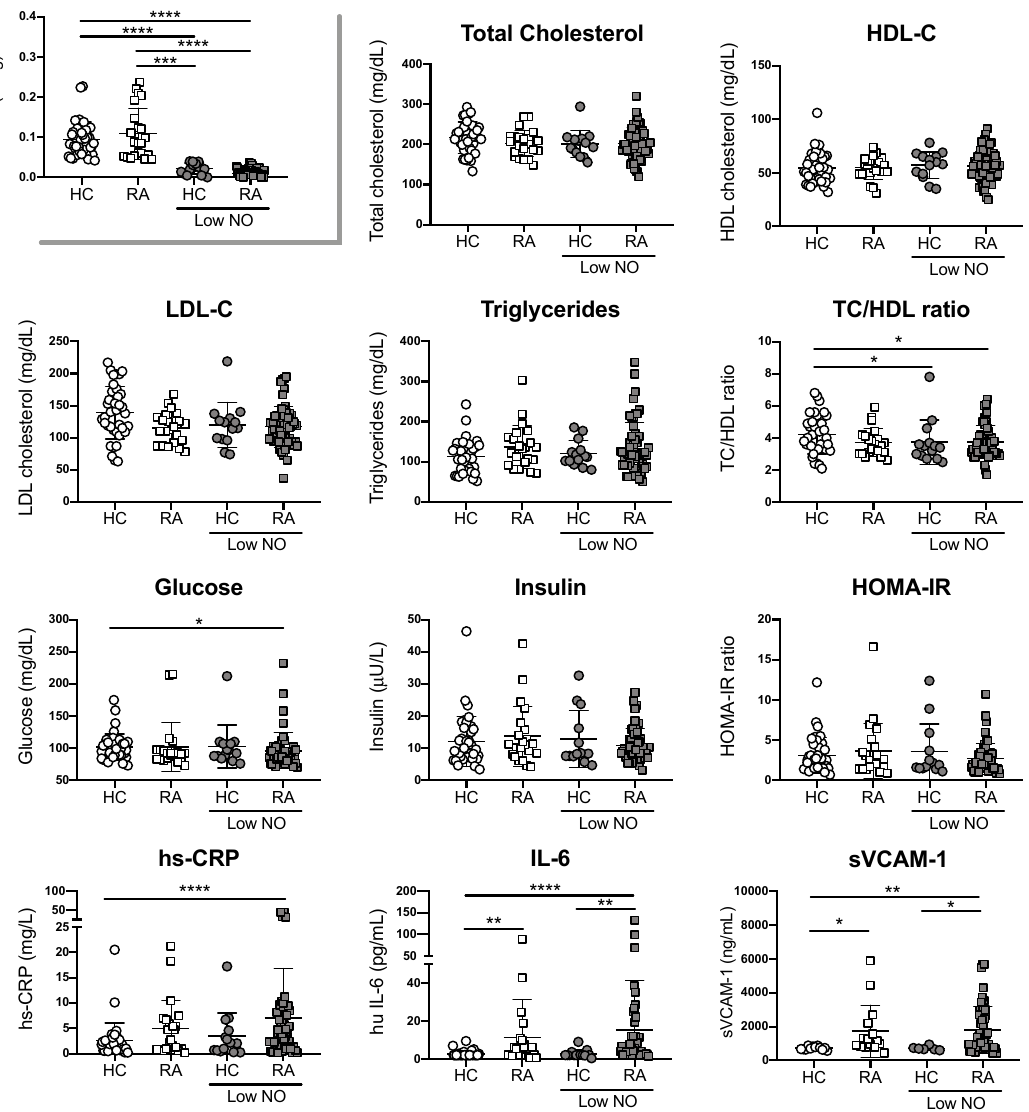
Figure 3. Decreased NO production is associated with inflammatory factors, but not with traditional risk factors. Traditional CV risk factors and concentration of hs-CRP, IL-6 and sVCAM-1 were measured in plasma from RA patients with normal or decreased NO and plasma from healthy controls (HC) with normal or decreased NO. Kruskal-Wallis test was used to compare RA patients and healthy controls, * P < 0.05, ** P < 0.01, *** P < 0.005 and **** P < 0.0001 was considered significant. Table 3. Disease characteristics in RA patients according to ROS production and NO synthesis. ROS NO Normal (n High (n = Normal (n Low (n = P P = 15) 57) = 22) 50)